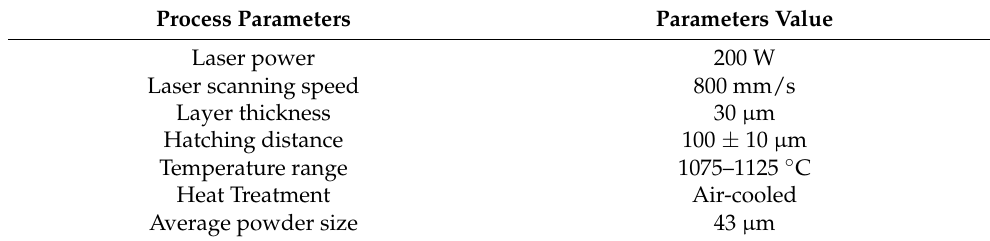
Table 1. SLM process